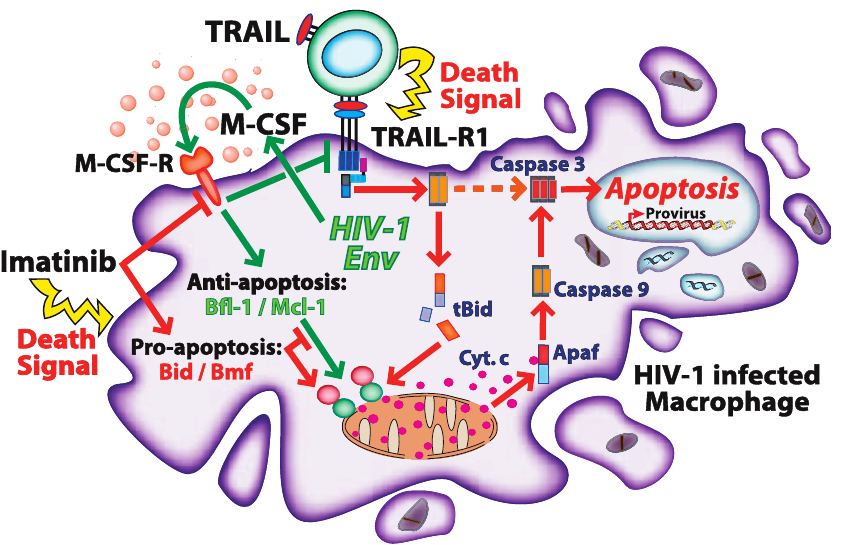
Figure 7. Experimental Model: Following HIV-1 Infection , De Novo Synthesized Viral Envelope Induces the Release of M-CSF M-CSF opposes TRAIL by suppressing TRAIL-R1 expression and upregulating the anti-apoptotic factors Bfl-1 and Mcl-1. The anti-cancer drug Imatinib disables the protective effect of envelope by inhibiting M-CSF activity. Upon inhibition of M-CSF activity, TRAIL-R1 expression is increased and the action of Bfl-1 and Mcl-1 is blocked by pro-apoptotic bcl-2 family proteins. Further exposure of infected macrophages to Imatinib for several days induces apoptosis in the absence of TRAIL and is associated with increased pro-apoptotic protein expression.